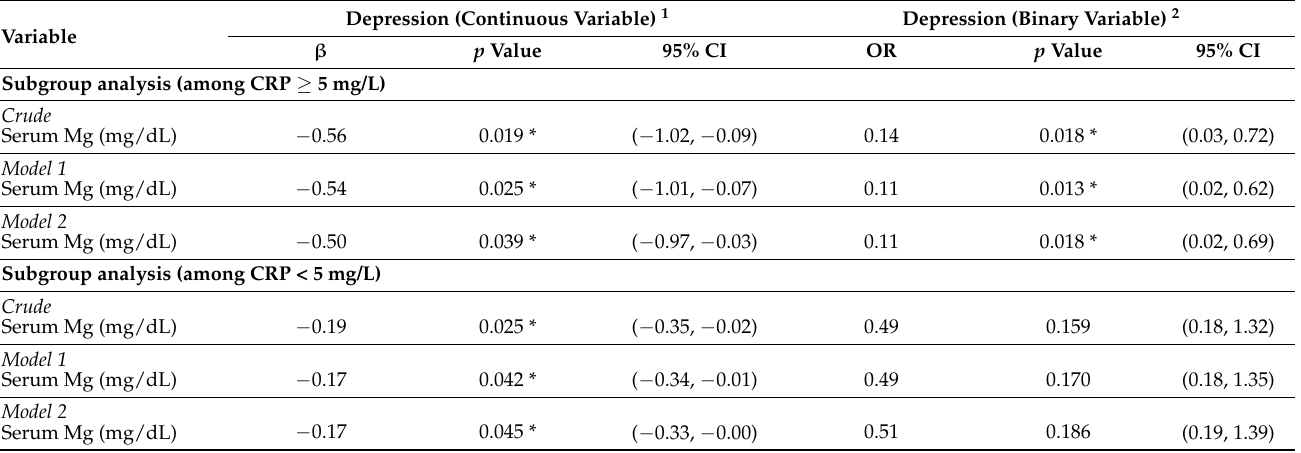
Table 3. Odds ratios and estimates of depression scores according to serum Mg levels by CRP